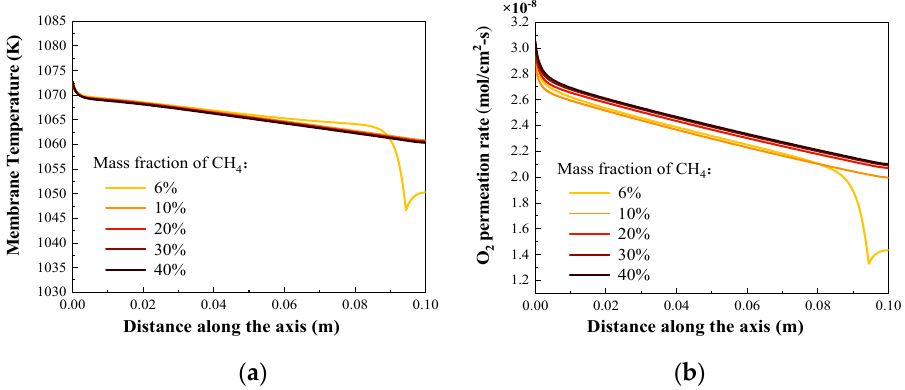
Figure 10. Effects of methane content on: ( a ) membrane temperature; ( b ) oxygen permeation rate.